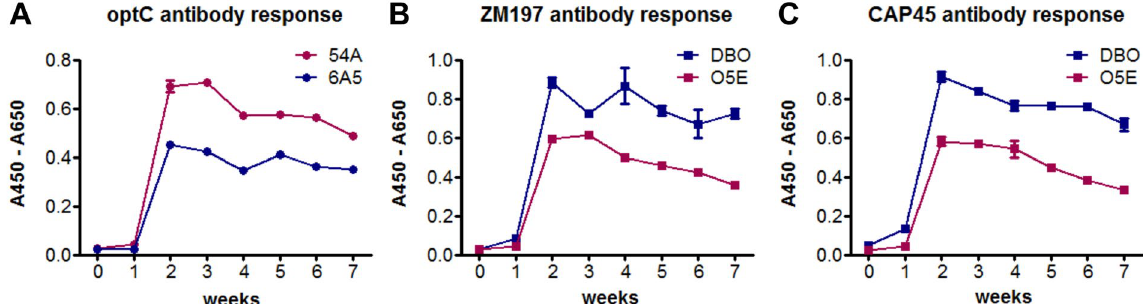
Figure 3. Env-specific antibody response in dromedary sera during the seven immunization boosts of the first immunization cycle. ELISA experiments showing ( A ) optC antibody response in sera from 54A (diluted 1:1,000, open circles) and 6A5 (1:200, black circles), ( B ) ZM197M antibody response in sera from DBO (1:120, open squares) and O5E (1:375, black squares) and ( C ) CAP45 antibody response in sera from DBO (1:120, open squares) and O5E (1:375, black squares). 0: preimmune sera, 1–7: serum samples after the respective immunization boosts. One representative experiment of two is shown. Error bars indicate SEM from triplicates.